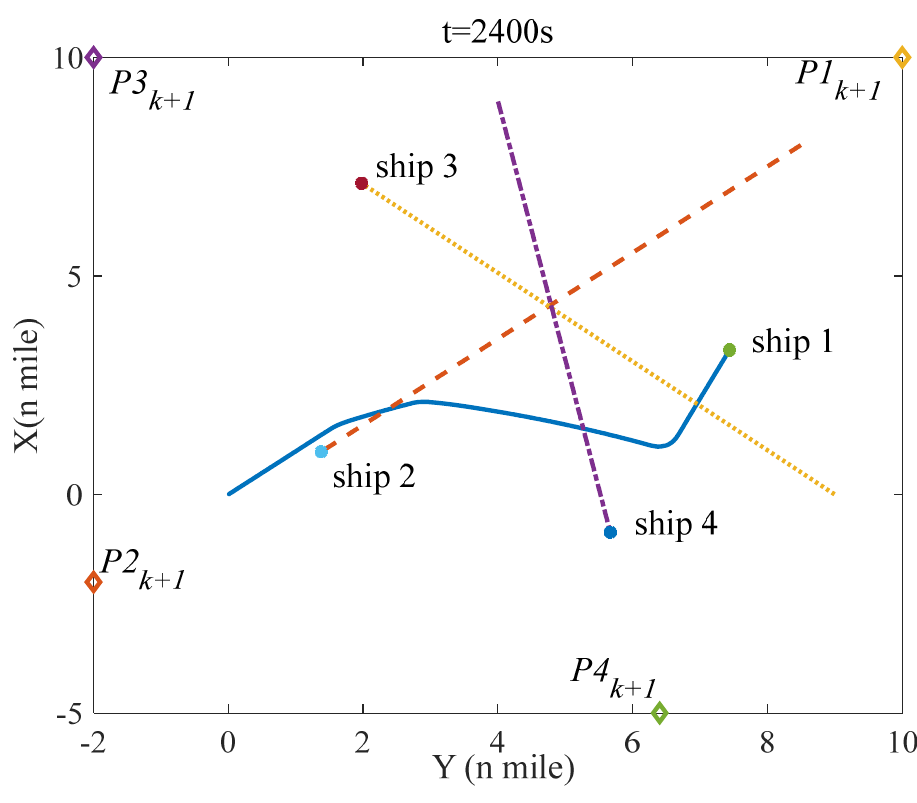
Figure 20. The situation of four ships at t = 2400 s in scenario 3.